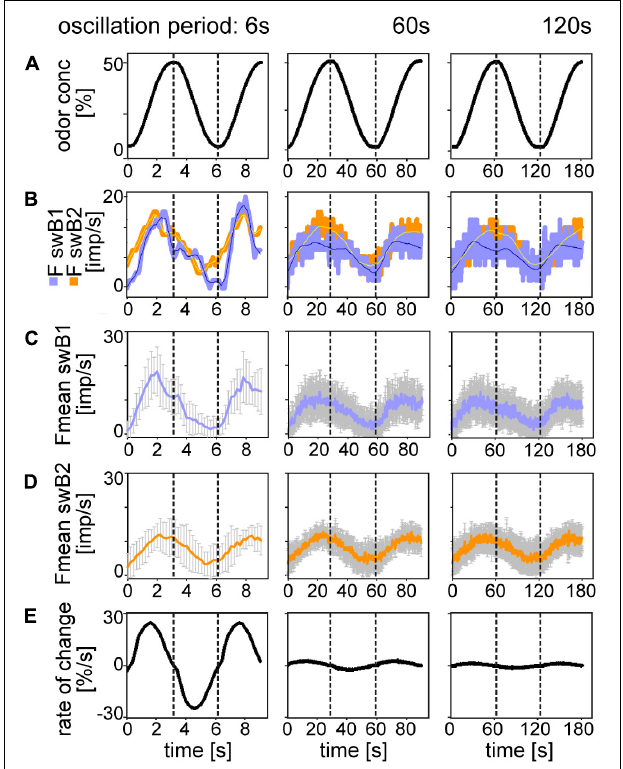
FIGURE 4 | Responses of the swB1 and swB2 ORNs to oscillating changes in odor concentration. (A) Time course of odor concentration for three different oscillation periods. (B) Time course of impulse frequency of the swB1 ORN (blue) and the swB2 ORN (orange). Thin lines are calculated frequency curves smoothing out sharp changes in direction without shifting the maxima and minima values . (C) Time course of mean impulse frequency and standard deviations for 6 swB1 ORNs. (D) Time course of mean impulse frequency and standard deviations for 7 swB2 ORNs. (E) Time course of the rate of concentration change for the three different oscillation periods. Different time scales were used to demonstrate whole oscillation periods. Dotted vertical lines indicate the phase shift between time courses of odor concentration, impulse frequency and rate of concentration